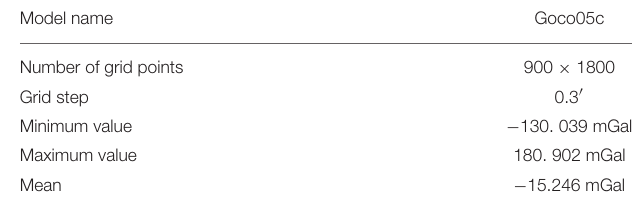
algorithm. In this paper, optimal parameter values of